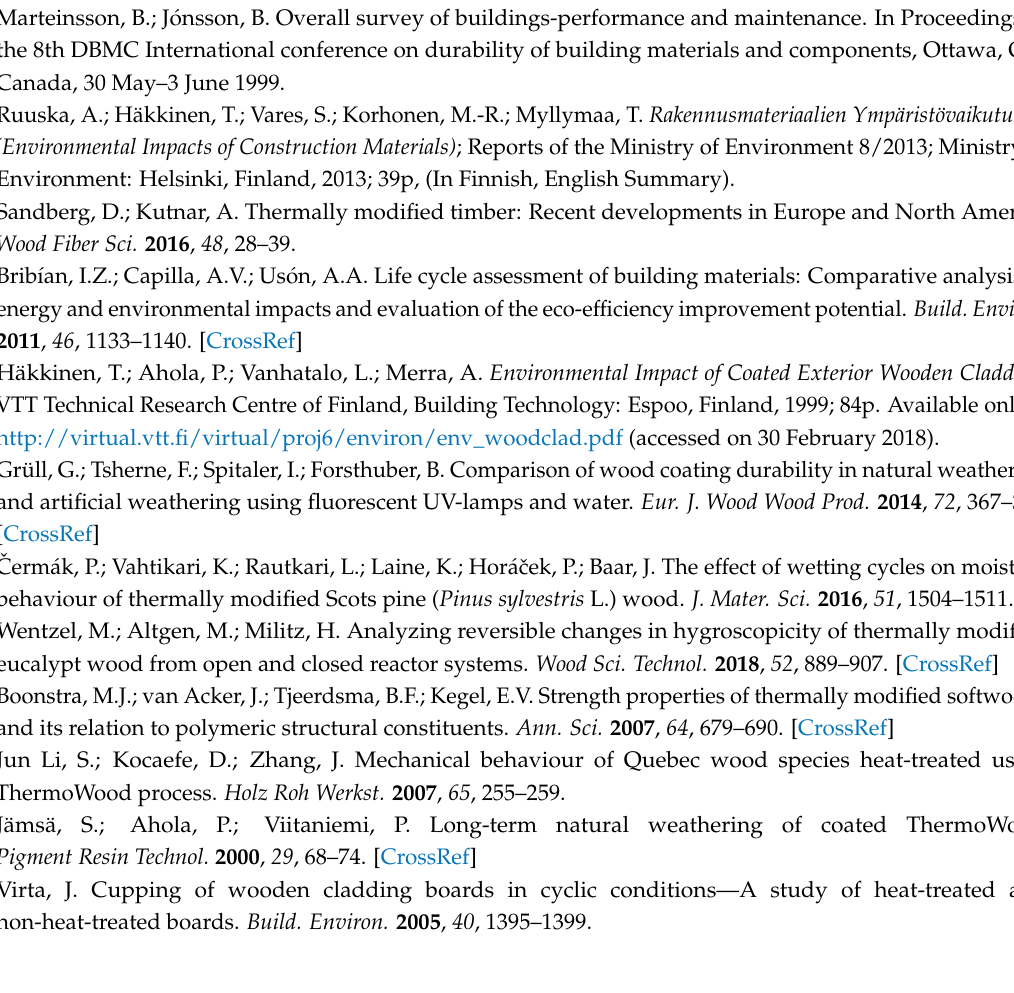
s1, Figure S1: Wettability measured by contact angle during a measurement period of 60 s; Figure S2: Density (kg m − 3 ) of charred samples measured at the distance of 0–22 mm from the charred